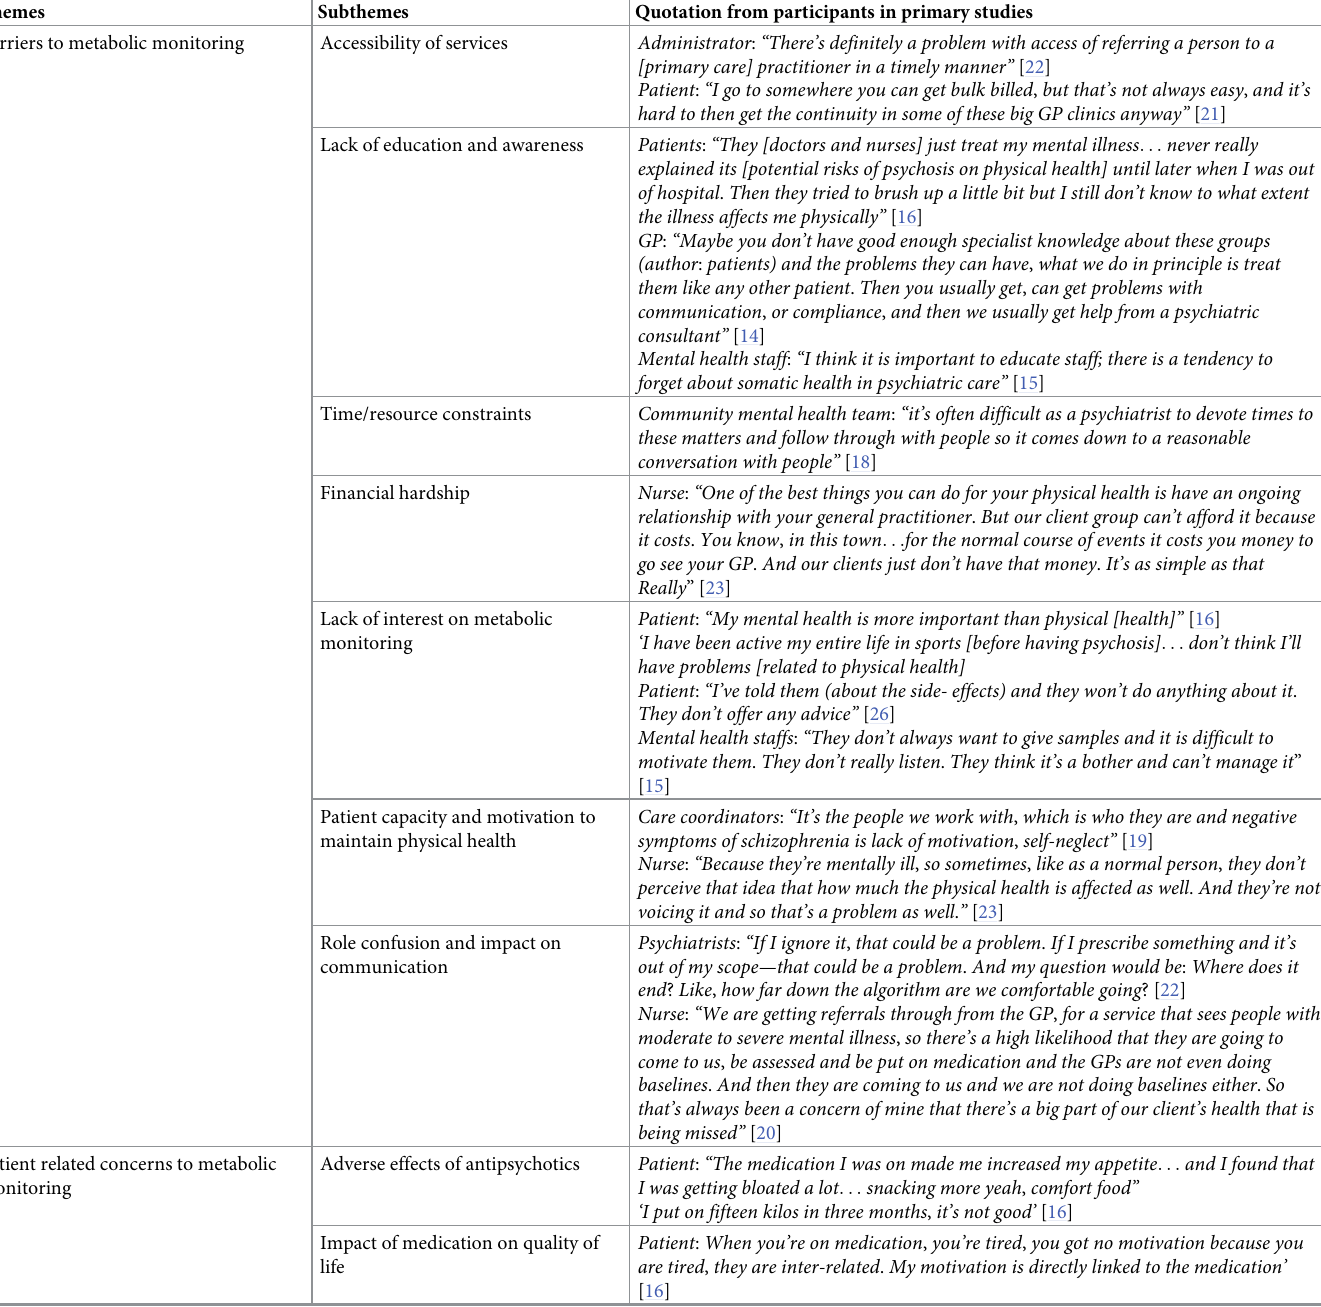
Table 3. Themes and subthemes arising from the analysis of the different studies along with quotations from participants of primary studies.